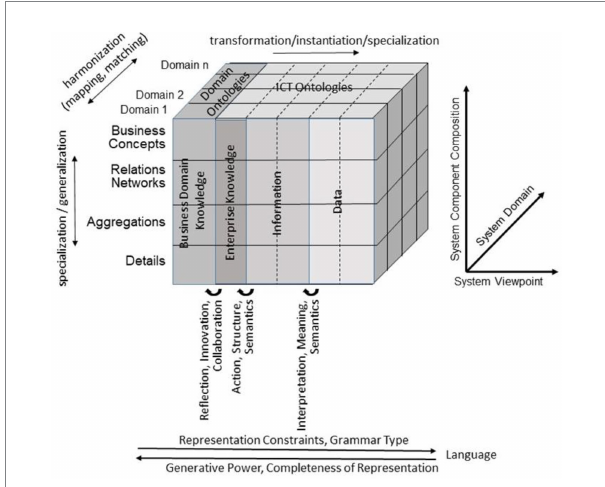
FIGURE 2 Transformed health and social care ecosystem acc. to ISO 23903 regarding the knowledge types in the ICT solution development process (after (11),